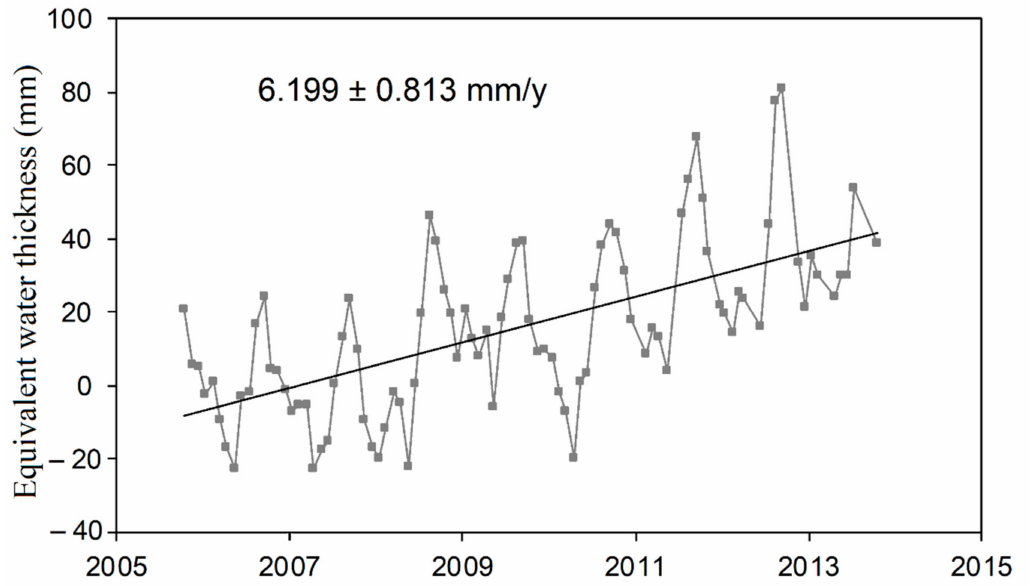
Figure 2. The changing trend of equivalent water thickness from GRACE data in the inner Tibetan Plateau during